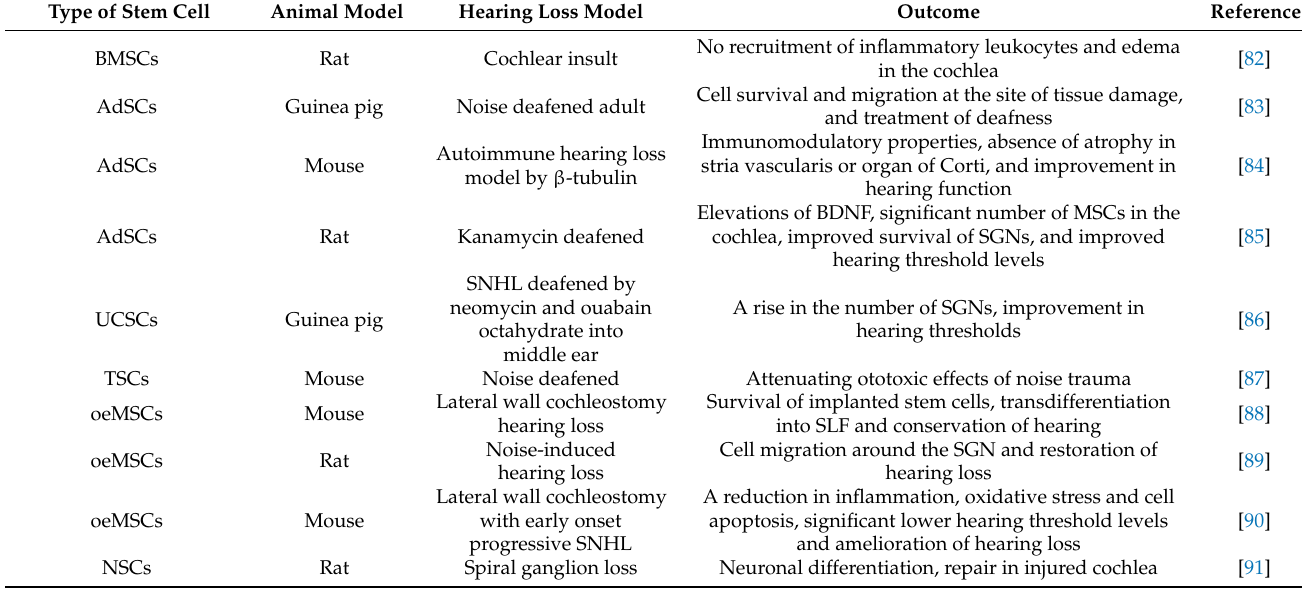
BMSCs: Bone marrow-derived stem cells. AdSCs: Adipose tissue-derived stem cells. TSCs: Tongue-derived stem cells. HSCs: Hematopoi- etic stem cells. UCSCs: Umbilical stem cells. oeMSCs: Olfactory epithelium neural stem cells. NSCs: Nasal tissue-derived stem cells. SLF: Sensory fibrocyte-like cells. SNHL: Sensorineural hearing loss. SGNs: Spiral ganglion neurons. NF-200: neurofilament-200, MAP-2: Microassociate protein-2, NeuN: Neuron-specific nuclear protein, GFAP: Gial fibrillary acidic protein, GFP: Green fluorescent protein. EGFP: Enhanced green fluorescence protein. BDNF: Brain-derived neurotrophic